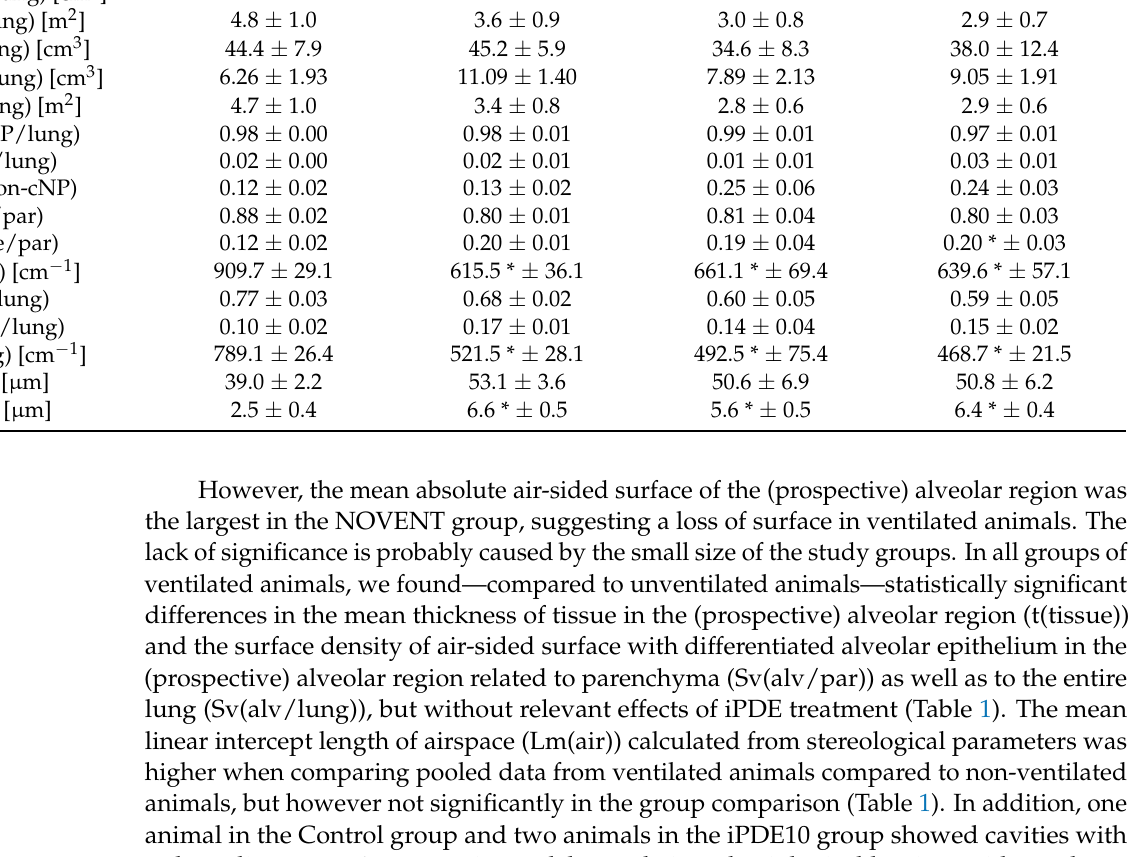
Table 1. Stereology of the lung in 15 of 21 animals (data given as mean ± SEM, * p < 0.05 vs. NO- VENT).